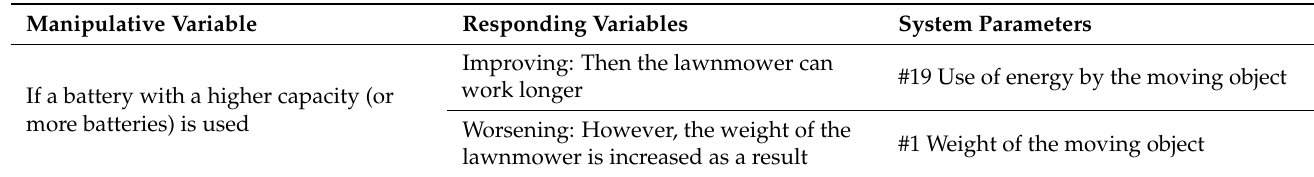
Table 8. Inventive principles from system parameters of technical contradictions (constraint